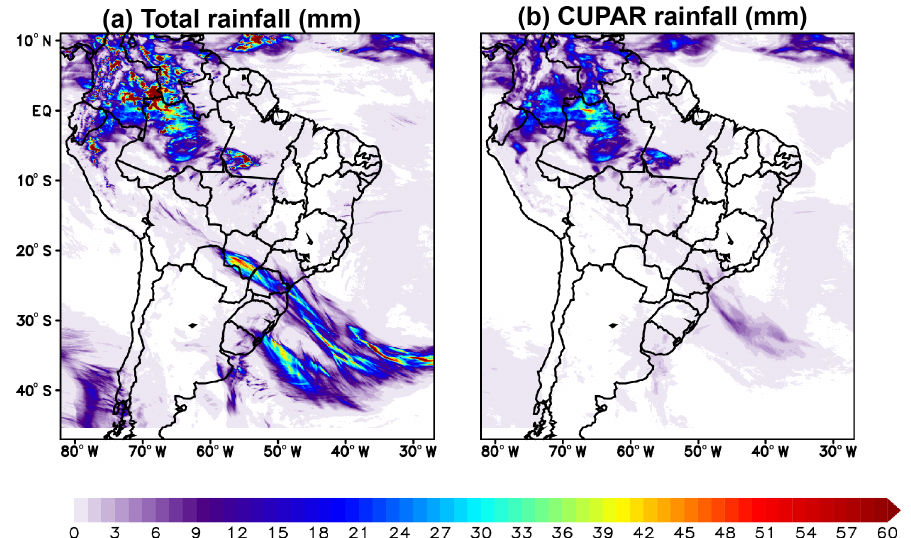
Figure 9. BRAMS model forecast of 24h accumulated (a) total precipitation and (b) from convective parameterization for 12 October 2015 and on 5km grid spacing. The unit is